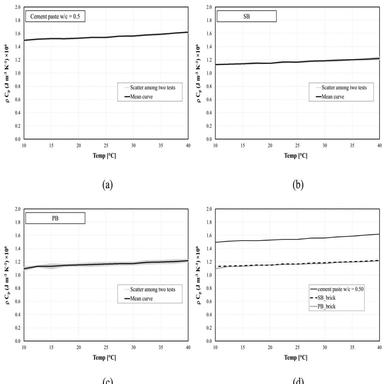
Results of DSC measurements obtained with a heating rate of 10 K × min–1 in terms of ρ × Cp of (a) cement paste with w/c = 0.50, (b) SB, (c) PB and (d) the comparison between them.